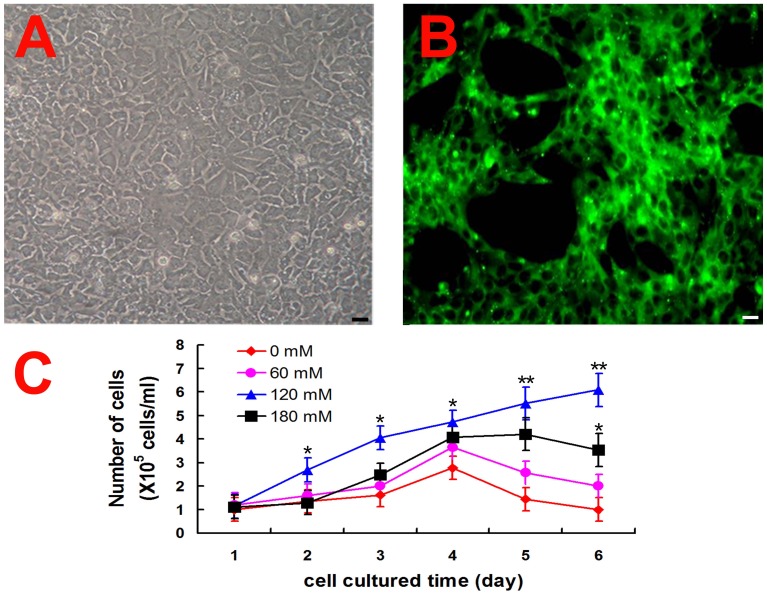
Effects of trehalose at different concentrations on proliferation of mouse epididymal epithelial cells in vitro.A, B) Isolation and CK-18 expression of epithelial cells from forty day mouse epididymis. A: First passage cells cultured in the medium with 120 mM trehalose. B: CK-18 expression of the cells. C) Growth curve of epididymal epithelial cells in the medium with different trehalose concentration. Bars represent means±S.D. * (p<0.05) and ** (p<0.01) indicated significant difference between 0 mM and other concentrations of trehalose. n = 4.